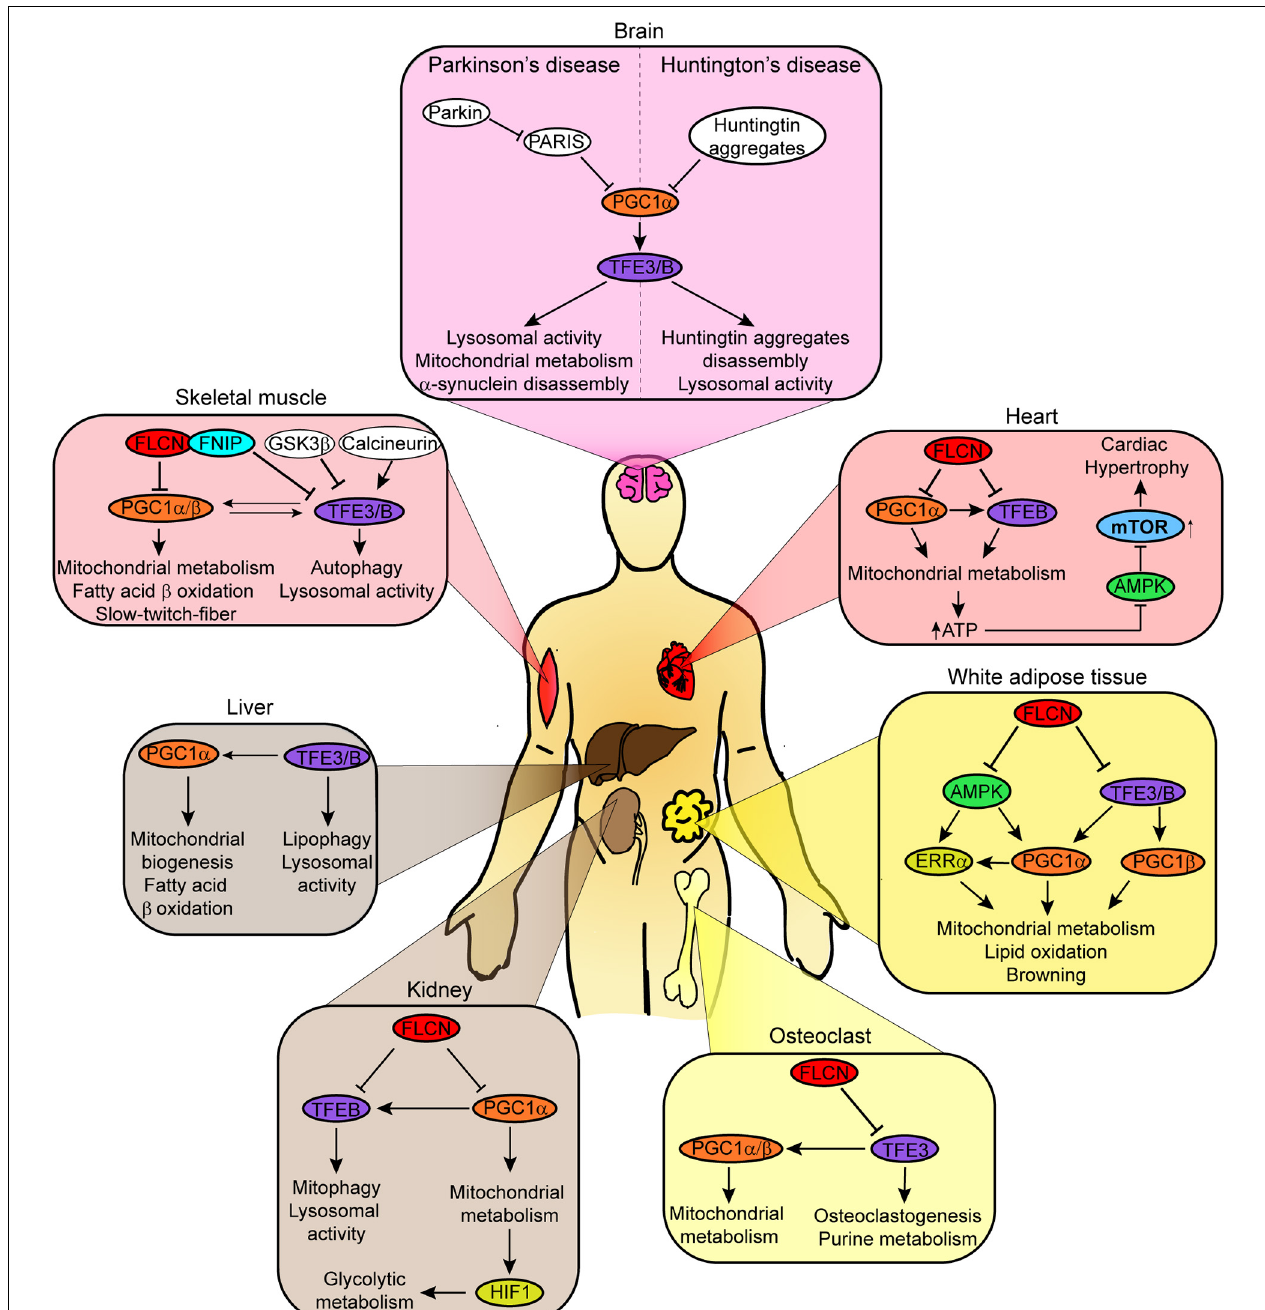
FIGURE 3 | Schematic diagram shows tissue-specific effect of FLCN depletion on the transcriptional activity of TFEB/TFE3 and/or PGC1 α / β . The metabolic processes affected by the specific regulatory mechanisms are indicated. AMPK and mTORC1 are only shown when mentioned in the corresponding references.